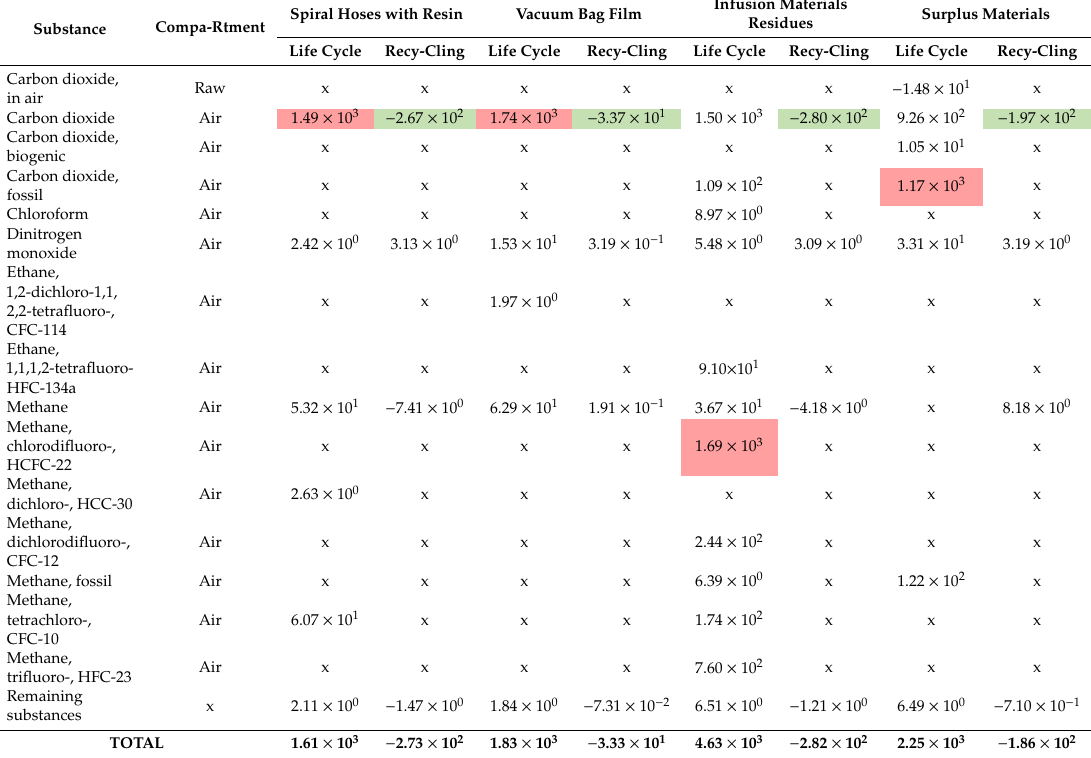
Red highlight—the highest level of negative environmental consequences for the emissions of the analyzed substances. Green highlight—the highest level of positive environmental consequences for the emissions of the analyzed